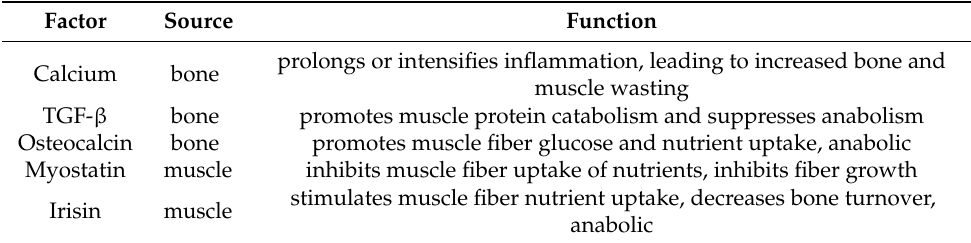
Table 1. Bone and muscle factors that affect muscle